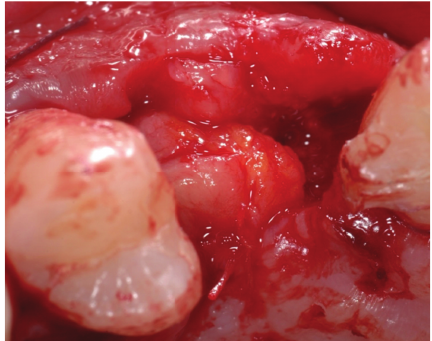
Figure 12: Connective tissue graft harvested from the palatal mucosa of the flap to increase soft tissue thickness.